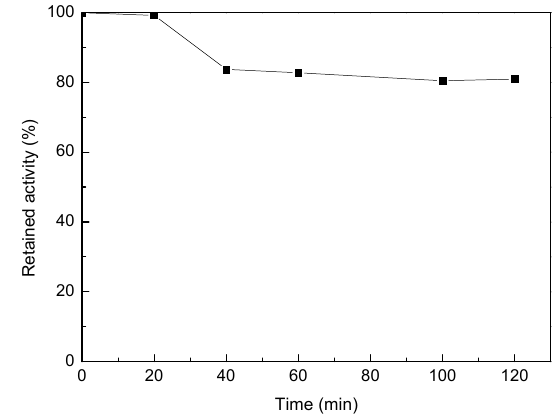
Figure 9. Stability of lipase in the even mixture of proteins at 25 °C and pH